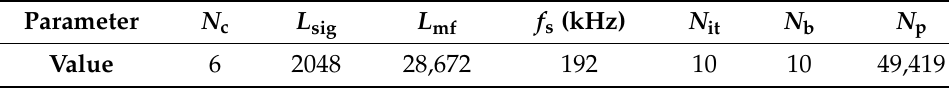
Table 2. Parameter of the coil signals used in this study.